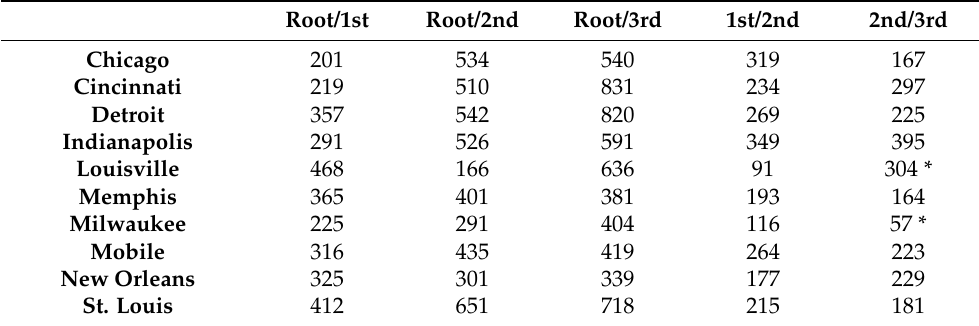
Table 1. Mean Migration Distance (MMD) by Generation Pair from those born in these Cities in 1850 (in miles).